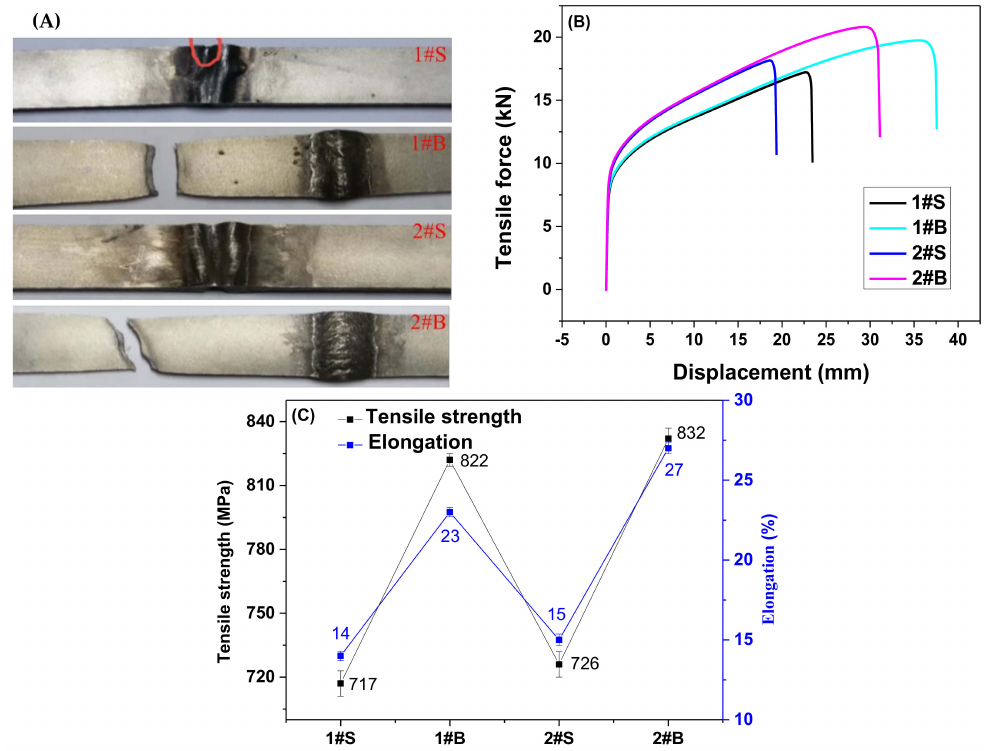
Figure 11. Tensile properties of welded joints: ( A ) Tensile samples; ( B ) tensile curves; ( C ) result of tensile tests.